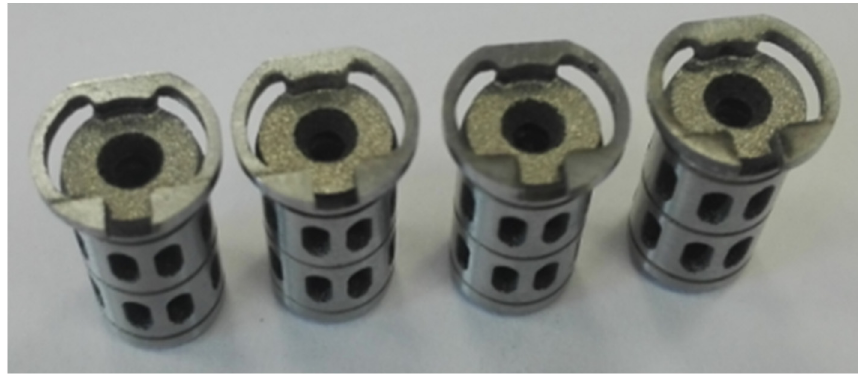
Figure 12. Actuator components made with AM technology ready for integration: primary control sleeves.